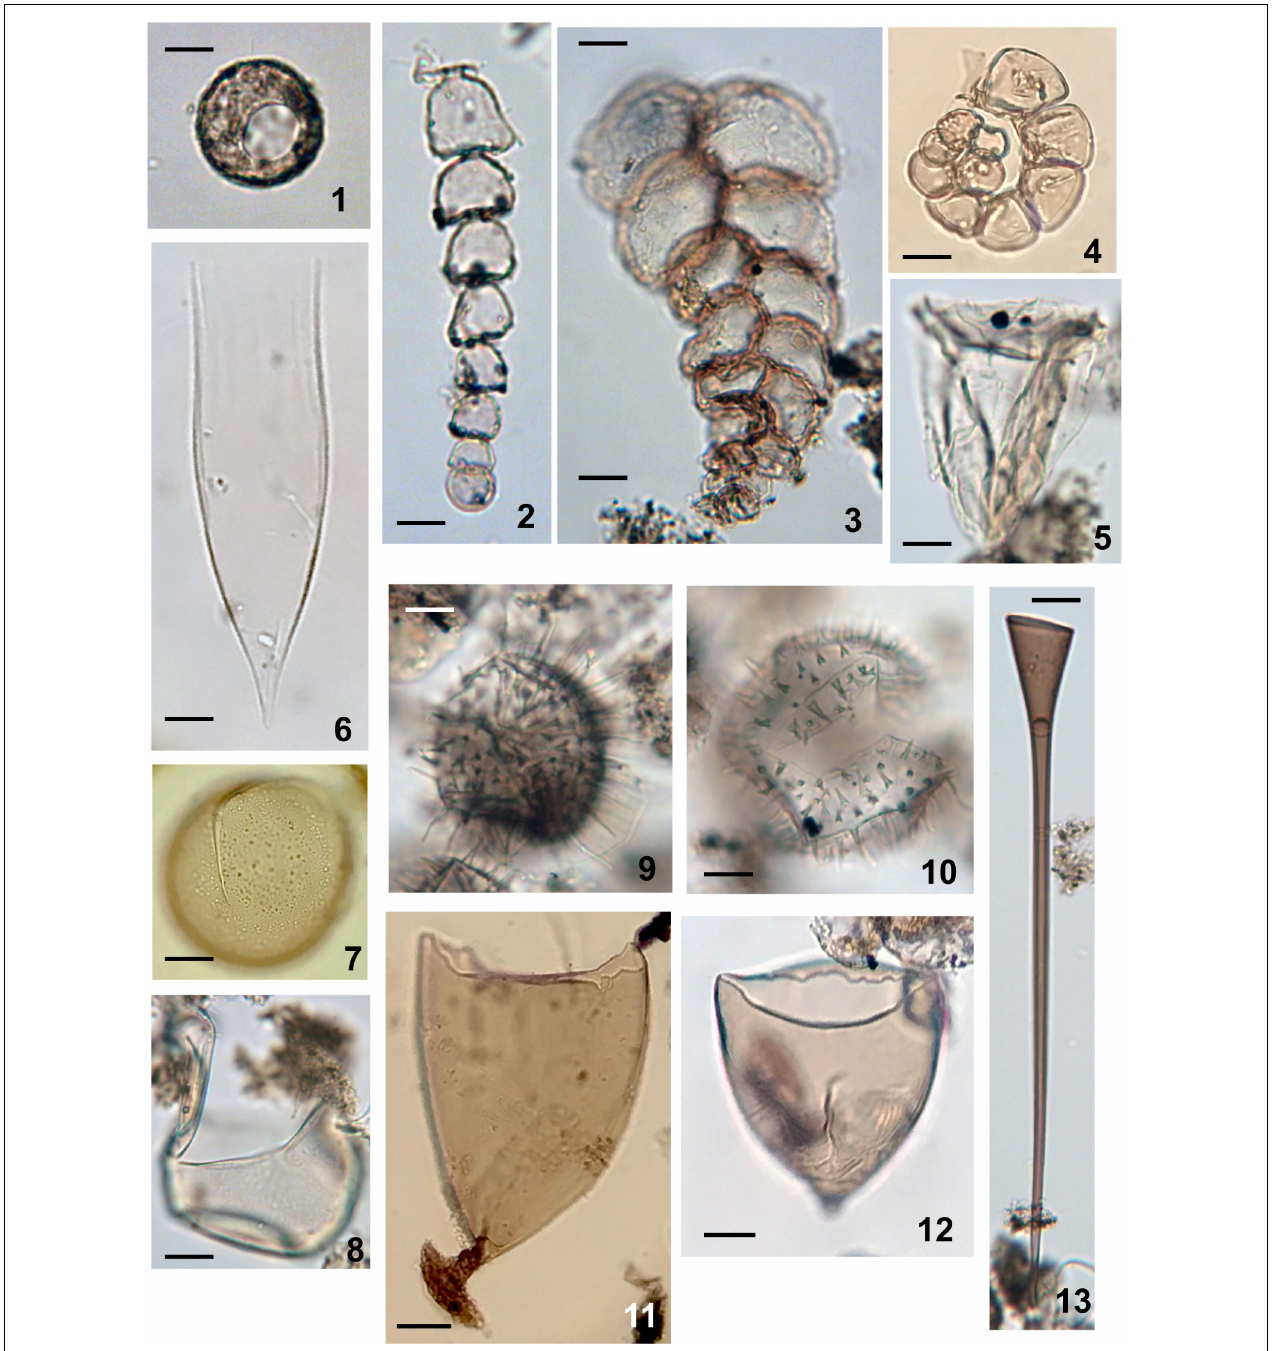
FIGURE 7 | Aquatic palynomorphs except for dinoflagellate cysts and acritarchs observed in sediments of Beppu Bay. (1) Testate amoeba; Arcella sp. Sample BG19 St 1-2 14-15. (2) Microforaminiferal lining uniserial type ( Reophax sp.). Sample BG 19 St 1-2 14-15. (3) Microforaminiferal lining biserial type ( Textularia cf. tenuissima ). Sample BG 19 St 1-2 14-15. (4) Microforaminiferal lining coiled type ( Buccella sp.). Sample BG 19 St 1-2 10-11. (5) Ciliate; Favella sp. Sample BG 19 St 1-2 14-15. (6) Ciliate; damaged lorica of Dadayiella sp. Sample BG 19 St 1-2 14-15. (7) Crustacean resting egg with finely granular surface. Arrow indicating rupture for hatching. Sample BG 19 St 1-2 14-15. (8) Crustacean resting egg with smooth surface. Arrow indicating rupture for hatching. Sample BG 19 St 1-2 14-15. (9) Crustacean resting egg ornamented with long flexuous spines. Sample BG 19 St 1-2 14-15. (10) Crustacean resting egg ornamented with short and solid spines. Arrow indicating rupture for hatching. Sample BG 19 St 1-2 14-15. (11) Turbellarian egg capsule with short and stout stalk. Arrow indicating basal attachment. Sample BP 09-6 3-89. (12) Turbellarian egg capsule with very short stalk. Sample BP 09-6 5-45. (13) Turbellarian egg capsule with very long stalk. Sample BG 19 St 1-2. (14-15) Scale bars; 20 µ